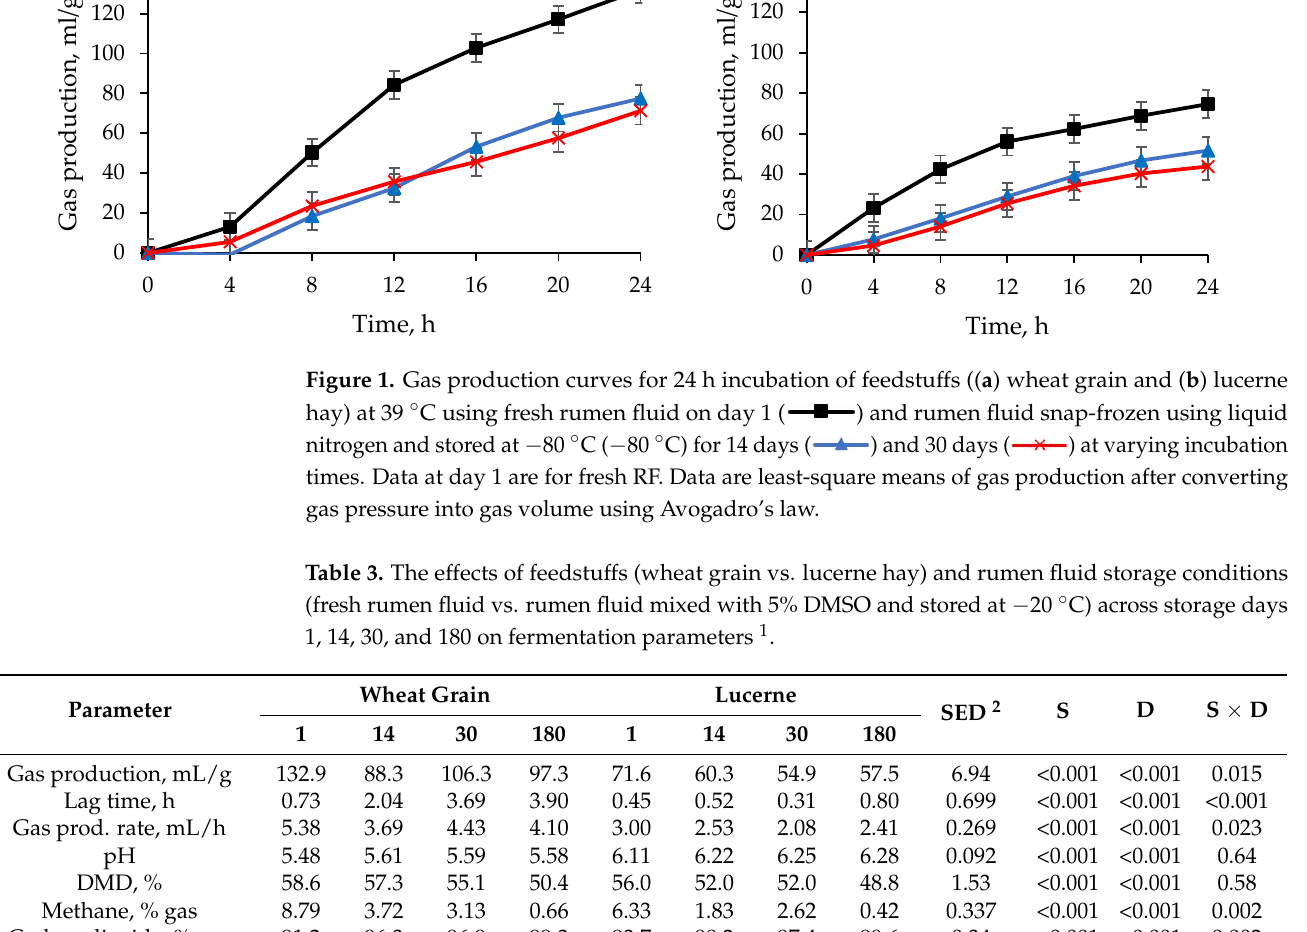
Table 3. The e ff ects of feedstu ff s (wheat grain vs. lucerne hay) and rumen fl uid storage conditions (fresh rumen fl uid vs. rumen fl uid mixed with 5% DMSO and stored at − 20 °C) across storage days 1, 14, 30, and 180 on fermentation parameters 1 .